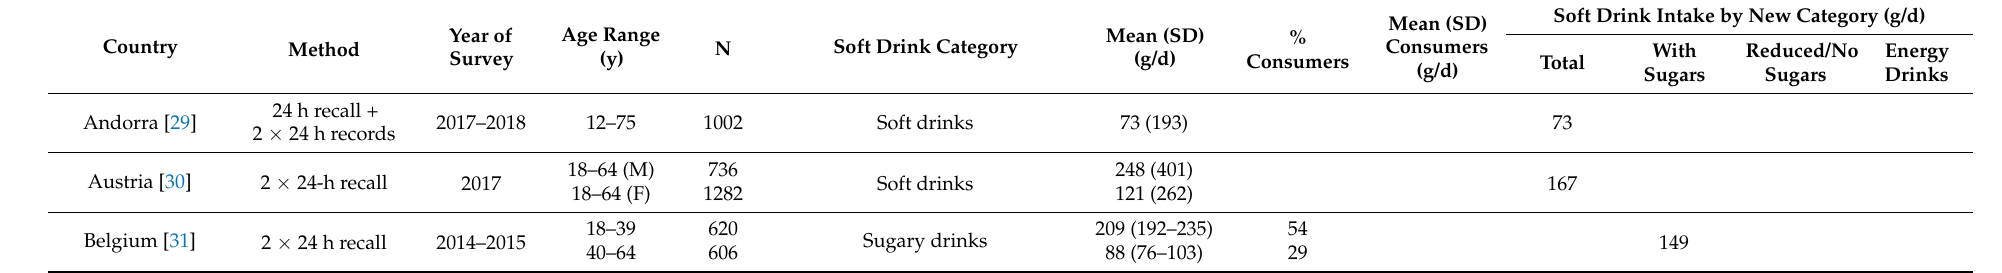
Table 5. Soft drink intake in adults(~18–64 y) in the WHO European Region, as reported in National Dietary Surveys and by new